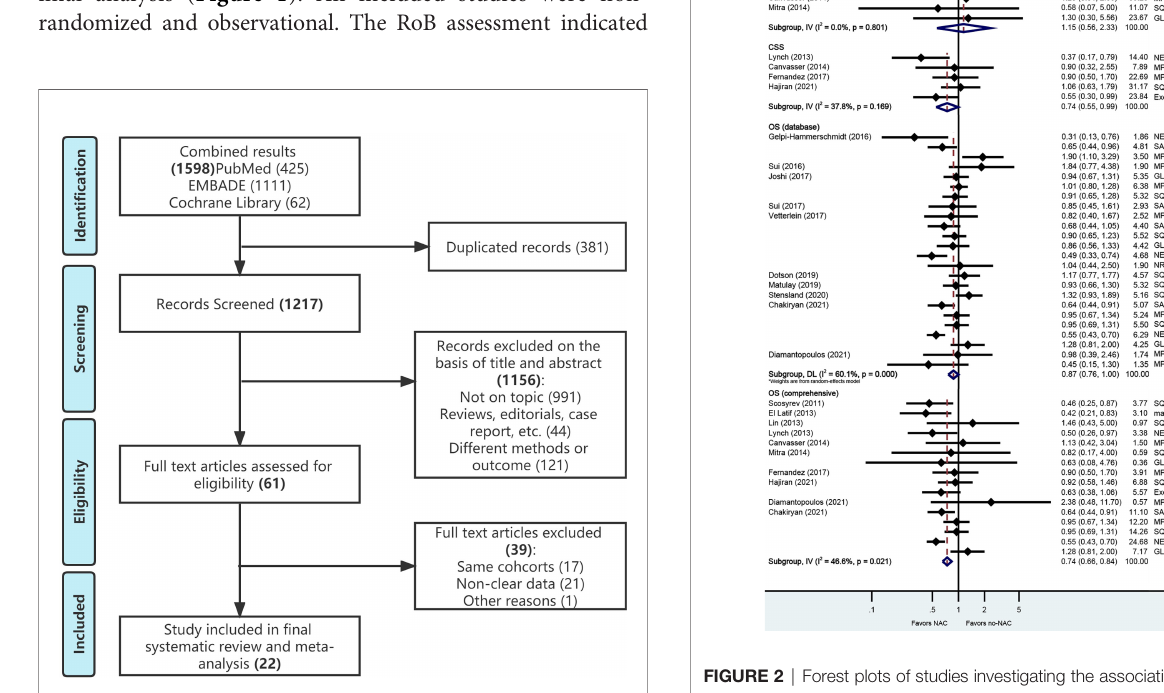
FIGURE 1 | Study selection fl owchart according to the Preferred Reporting Items for Systematic Reviews and Meta-Analysis guidelines.